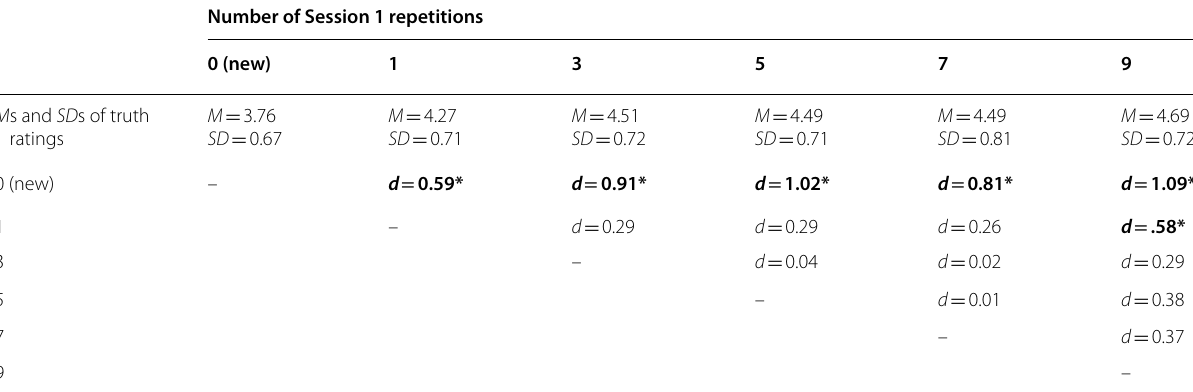
Table 1 Experiment 1 truth ratings as a function of repetition condition and the pairwise comparison effect sizes between repetition